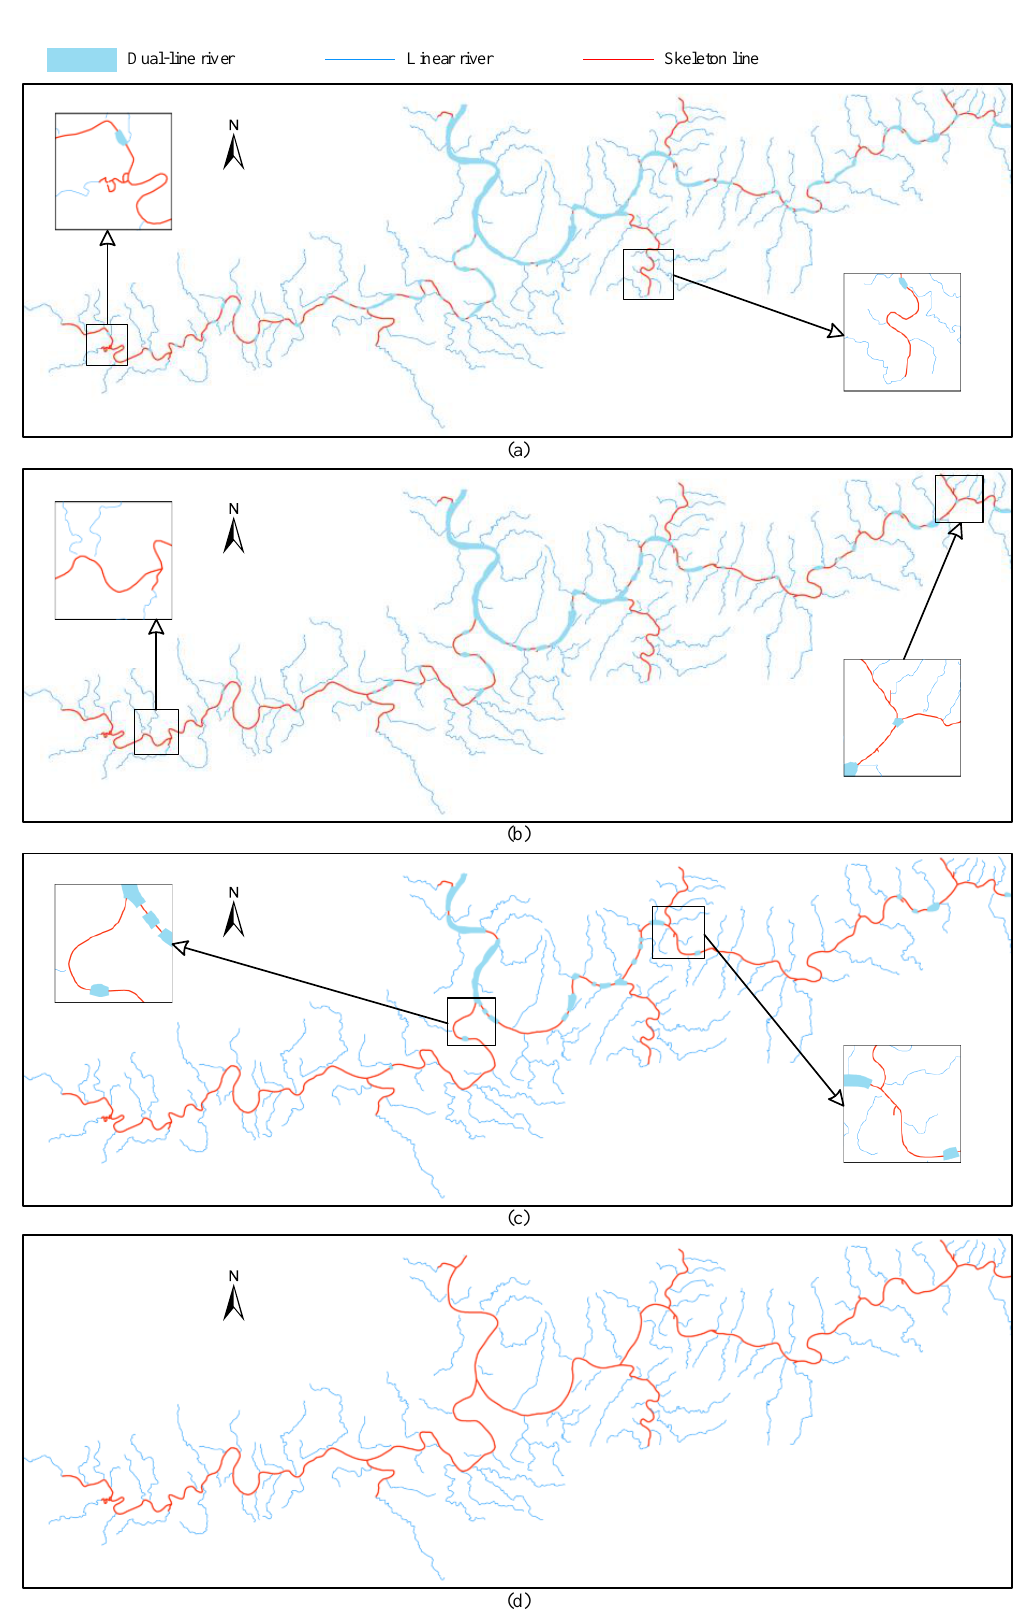
Figure 14. Progressive collapse results of the superpixel river collapse (SURC) method: ( a ) Level 4 superpixel collapse; ( b ) Level 3 superpixel collapse; ( c ) Level 2 superpixel collapse; ( d ) Level 1 superpixel collapse.